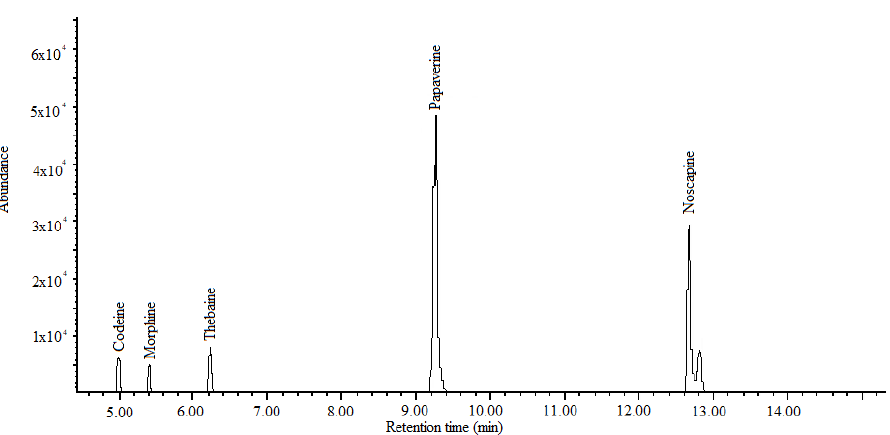
Figure 2. Total ion chromatography (TIC) obtained for each opium alkaloid using the SIM mode for a poppy seed tea extract spiked at a low level of validation (100 µg/L).